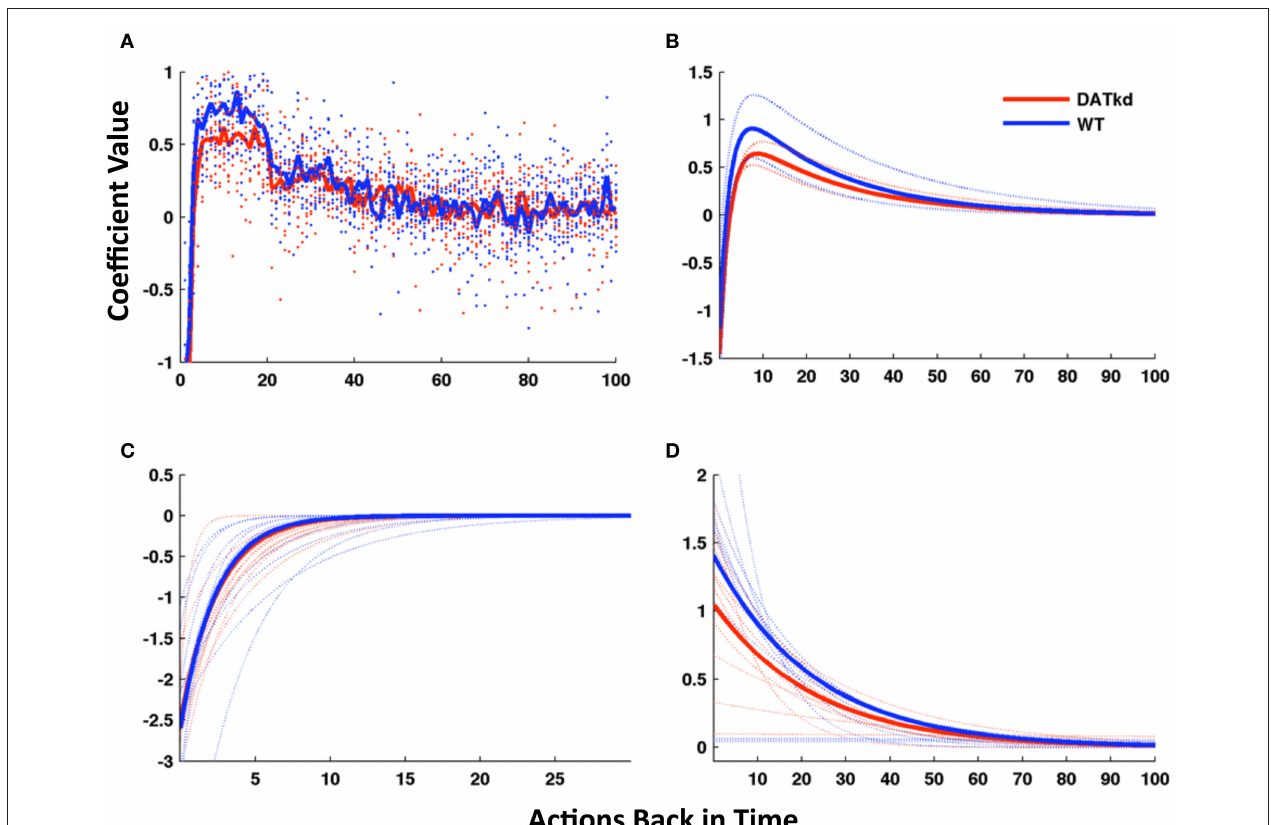
incorporates the effect of reward infinitely back in time, only the first 100 actions back are shown. Light traces show curves plotted ± standard error of parameters within groups. (C,D) The two exponentials of the model plotted separately. Solid lines represent model using group means of parameters and light traces represent individual subjects. See Table 2 for statistics. N = 10.